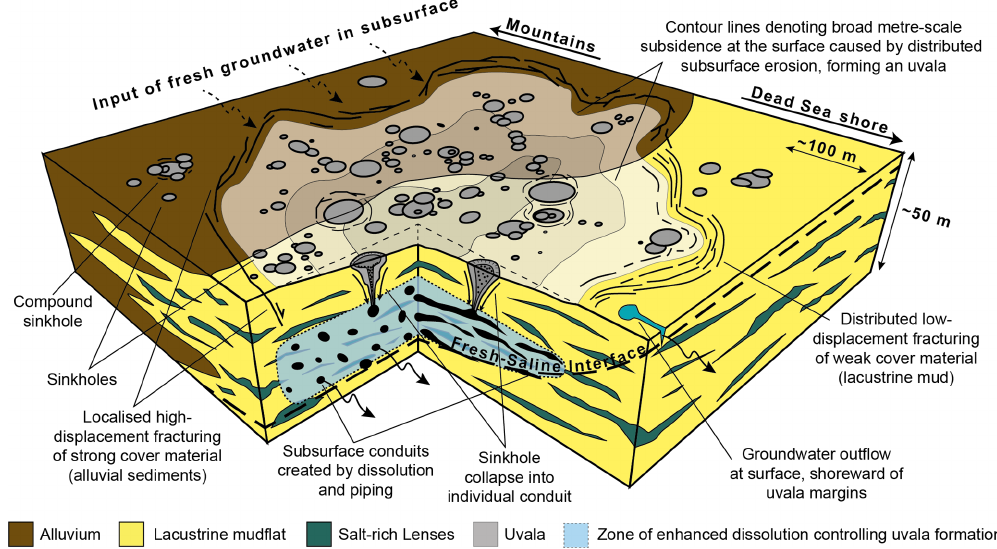
Figure 10. Schematic depiction of an uvala, its relationship to sinkholes and the inferred subsurface processes governing their formation in the evaporite karst setting of the Dead Sea. The influence of dissolution and piping on sinkhole and uvala formation is demonstrated, along with the relationship of uvala formation to sinkhole coalescence, which occurs both within and outside the spatial extent of the uvala. The spatial extent of the uvala (grey shading with contour lines) is defined by surface fracturing delineating broad surface subsidence. The expression of these fractures depends upon the host